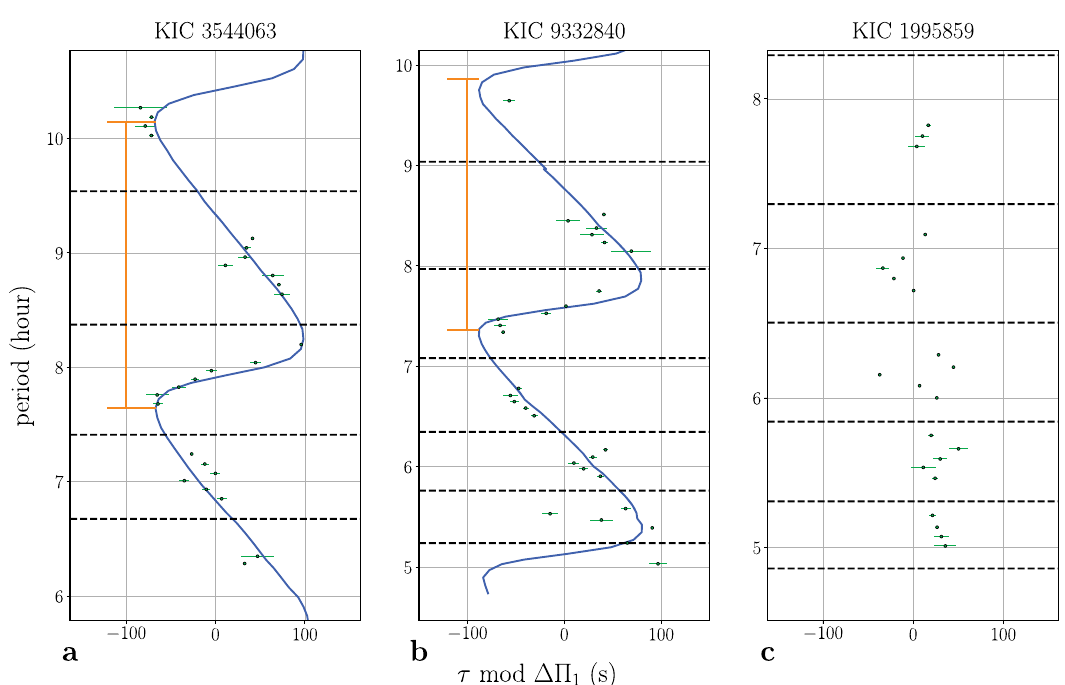
Fig. 4 | Échelle diagrams for three stars in our sample. Observed mixed mode periods (green dots) as a function of the stretched periods ( τ ) modulo ΔΠ 1 in an échellediagram for the starsKIC3544063 ( a ),KIC9332840 ( b ) and KIC1995859( c ). The uncertainties were computed following the fi tting technique described in method subsection Core glitches identi fi cation and characterization. The blue line